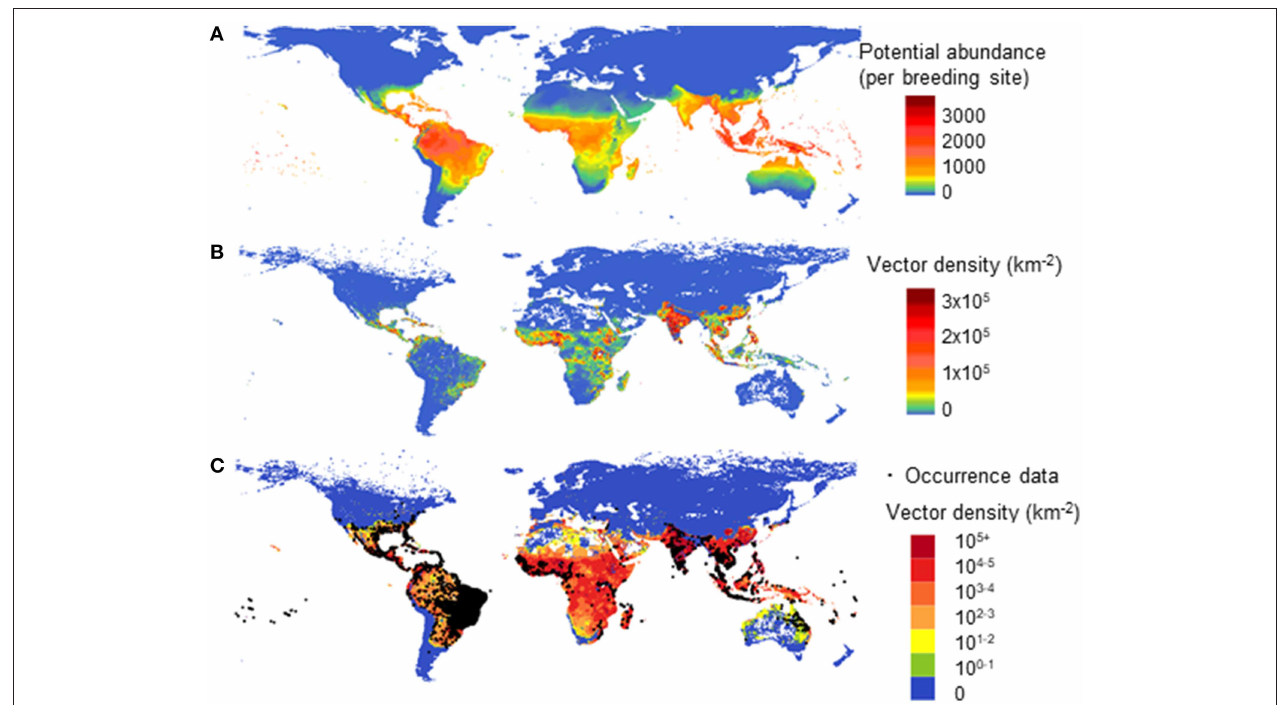
FIGURE 5 | Model comparison of different drivers on the global distribution for potential abundance and vector density of female Aedes aegypti : using climate only ( A —Model A) and climate, human population and GDPpc ( B,C —Model B). (A) shows potential vector abundance (per larval site) averaged over the decade 2000–2009 in linear scale. (B,C) show population density averaged over 2006–2015 in linear scale (B) and in log scale where occurrence data was also overlaid (C) .